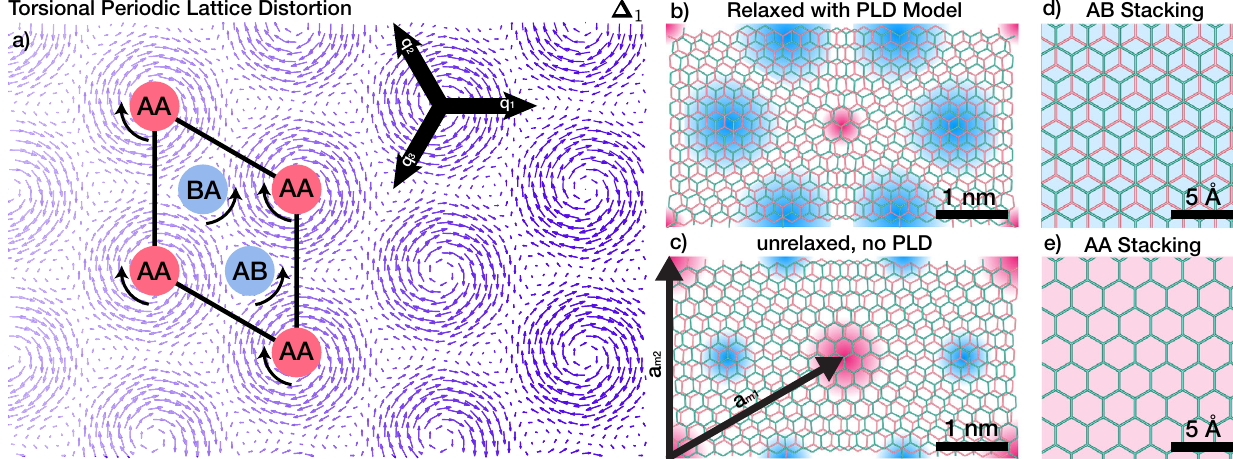
Fig.1|Periodicrestructuringoftwistedbilayergraphene(TBG).a Displacement fi eld of torsional PLD. Local rotational fi elds for the AA region and AB/BA regions areopposite.Byincludinghigherharmonics,PLDcanexhibitanyarbitrarypattern. The moiré supercell crystal structures of c pristine TBG and b restructured TBG with torsional PLD model. Red and blue overlay highlights energetically